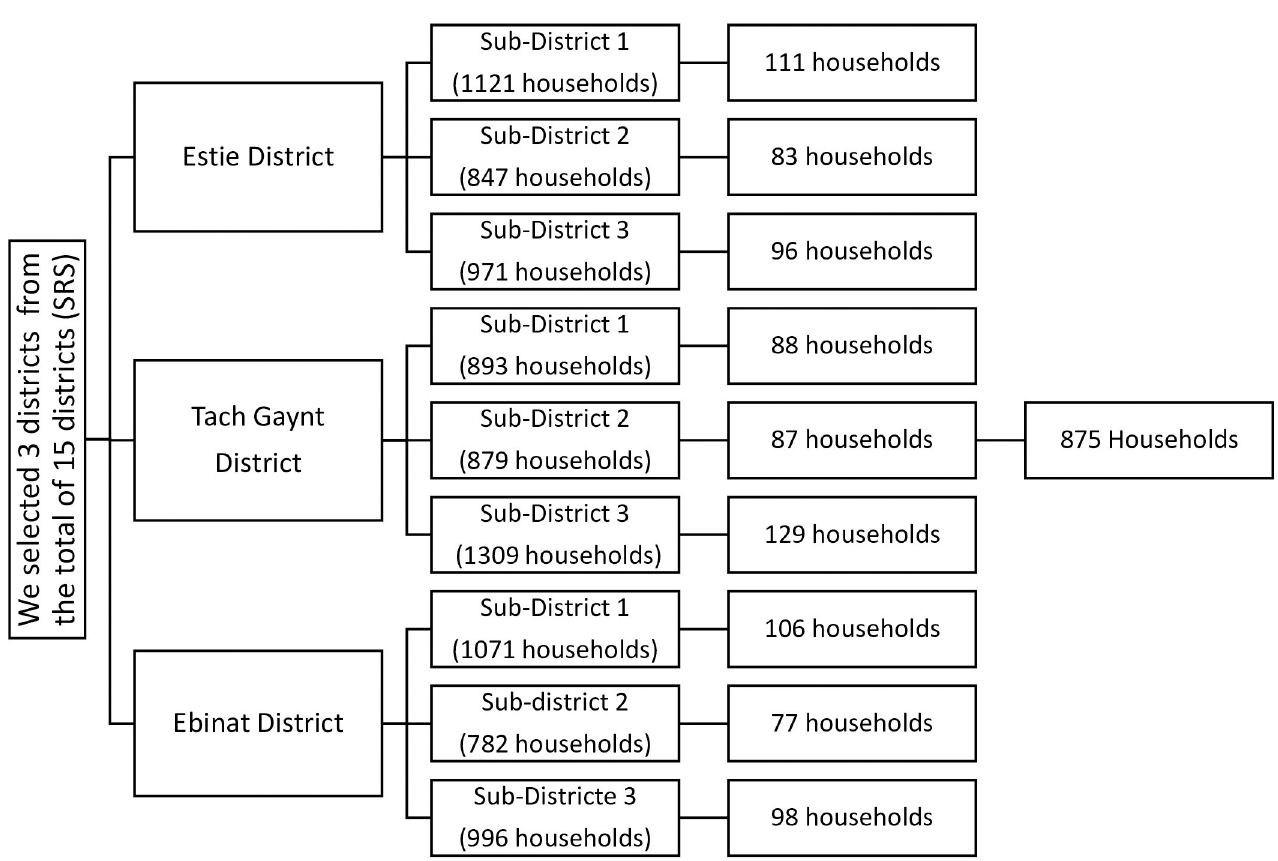
Fig 1. Schematic presentation of sampling procedure in adult residents of south Gondar zone, northwest Ethiopia, 2020. n = 875.